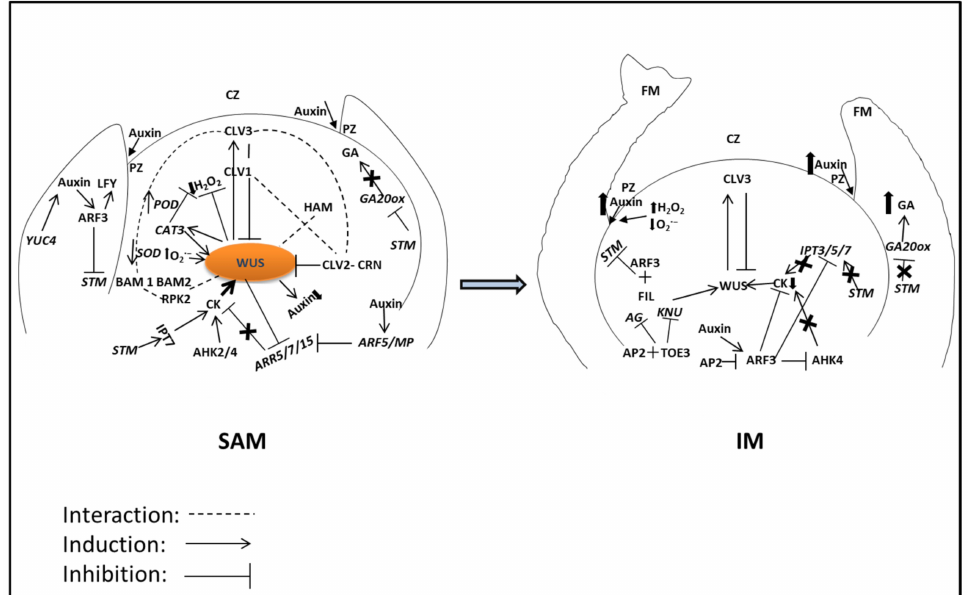
Figure 3. Regulatory network of WUS-CLV feedback loop in SAM maintenance and its transition to the inflorescence meristem (IM). Genes involved in the SAM, IM, and floral meristem (FM) are spatial and temporally regulated by several factors including phytohormones. AG, AGAMOUS; AHK, ARABIDOPSIS HISTIDINE KINASE; AP, APETALA; ARF, AUXIN RESPONSE FACTOR; ARR, ARABIDOPSIS RESPONSE REGULATORS; BAM, BARELY ANY MERISTEM; CAT, CATA- LASE; CK, CYTOKININ; CLV, CLAVATA; CRN, CORYNE; FIL, FILAMENTOUS; GA, GIBERELLIC ACID; GA20OX, GA20 OXIDASE; H 2 O 2 , HYDROGEN PEROXIDE; HAM, HAIRY MERISTEM; IPT, ISOPENTENYL TRANSFERASE; KNU, KNUCKLES; LFY, LEAFY; MP, MONOPTEROS; O 2 •− , SU- PEROXIDE; POD, PEROXIDASE; RPK, RECEPTOR-LIKE PROTEIN KINASE; SOD, SUPEROXIDE DISMUTASE; STM, SHOOT MERISTEMLESS; TOE, TARGET OF EAT; WUS, WUSCHEL; YUC, YUCCA. CZ, central zone; PZ, peripheral zone. Other regulatory factors/genes have been avoided due to its complexity and out of focus of this